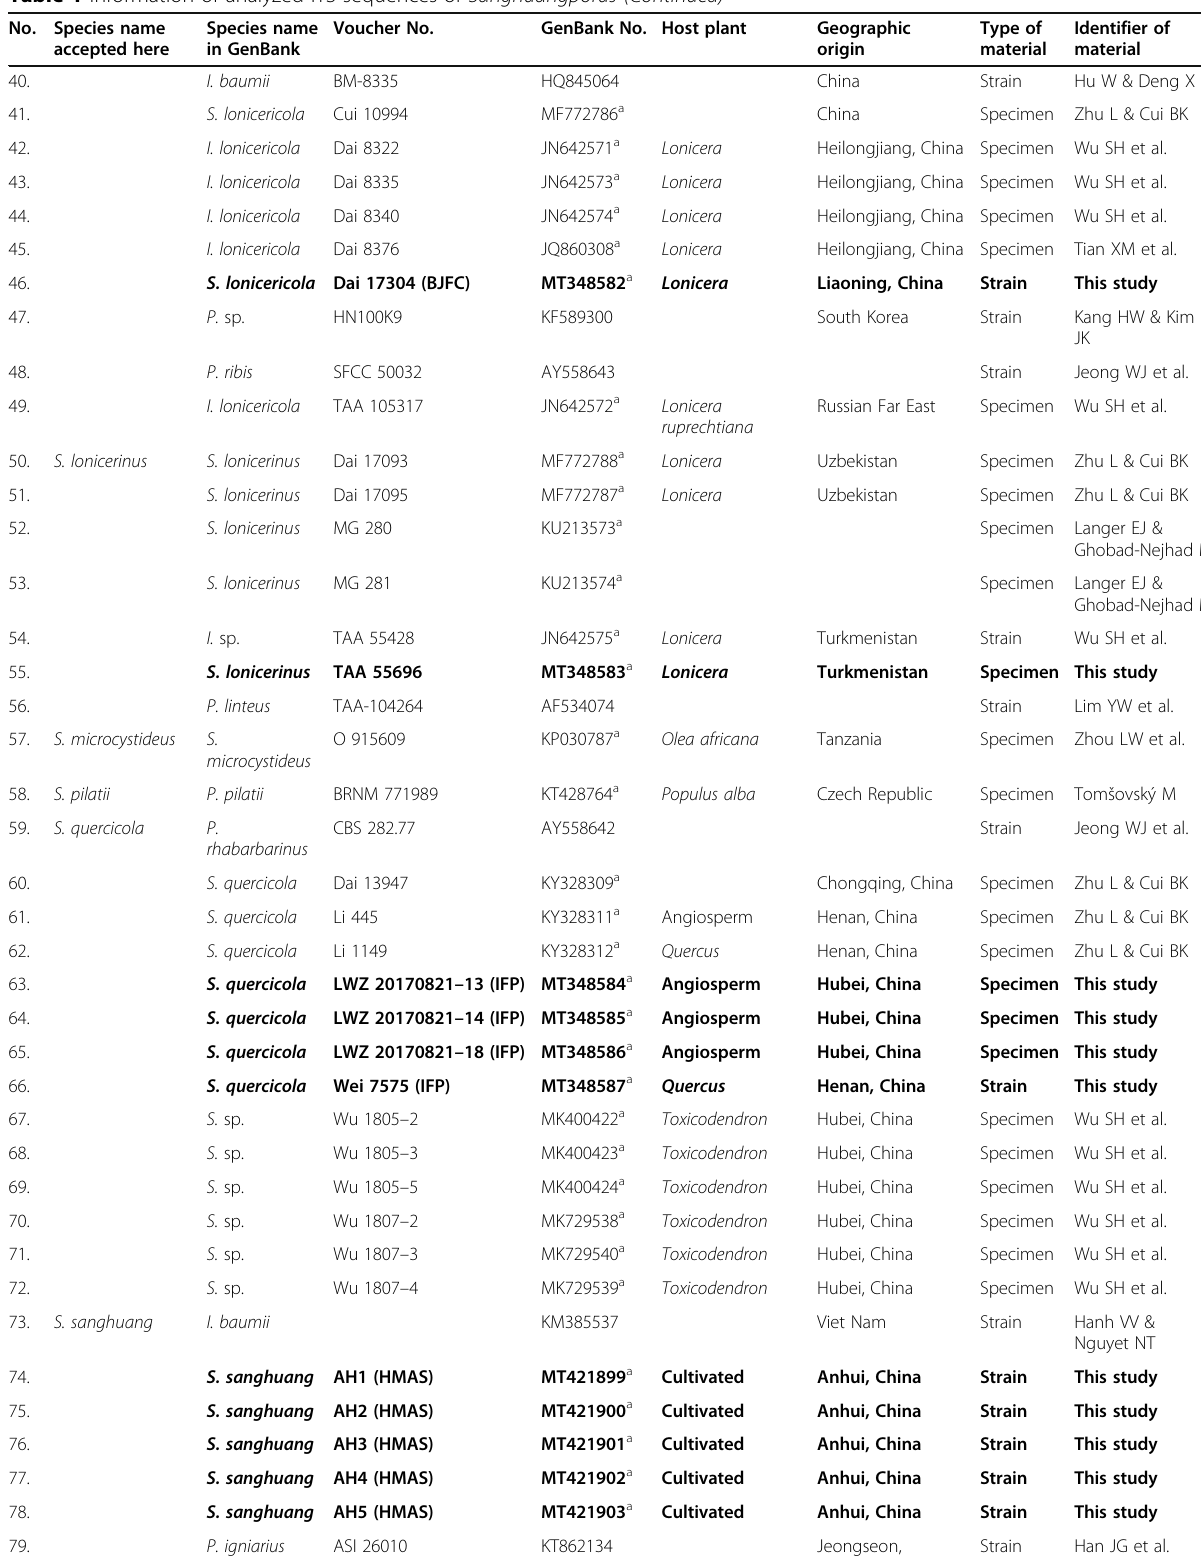
Table 1 Information of analyzed ITS sequences of Sanghuangporus